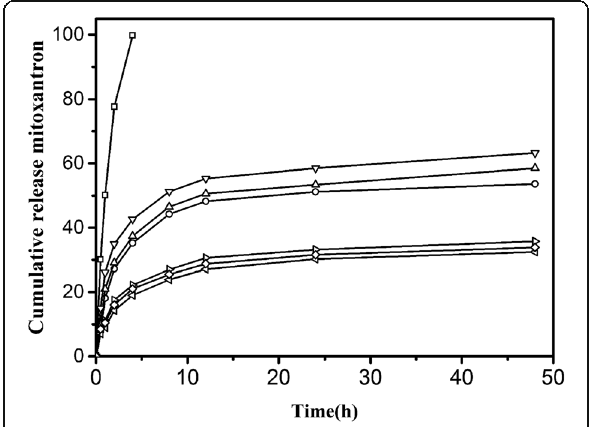
Fig. 9 Mitoxantrone (MTO) release of pullulan NPs in phosphate- buffered saline (PBS) at 37 °C in vitro ( □ : free mitoxantrone, ○ : CHP, △ : CHAP, ▽ : CHSP, ◁ : CHAP – HSA, ◇ : CHP – HSA, ▷ : CHSP – HSA)